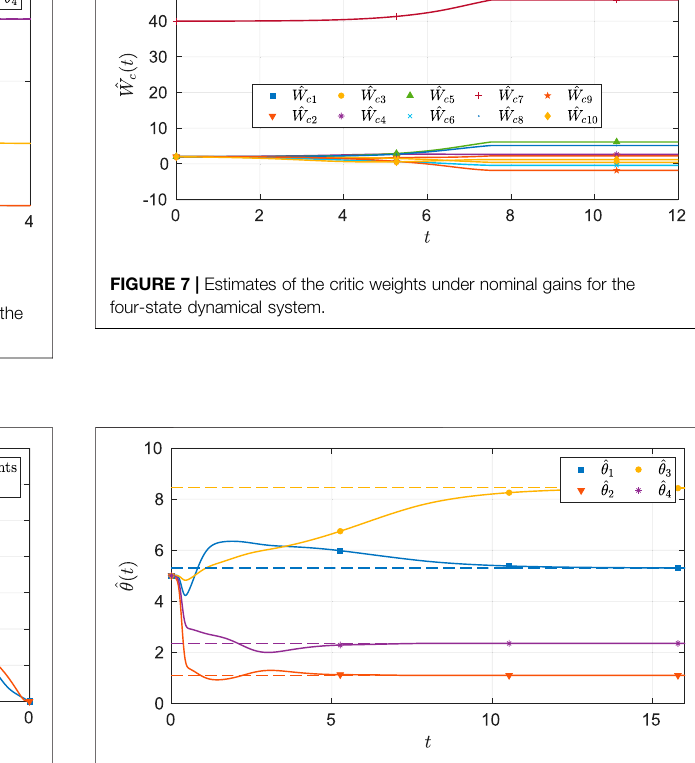
FIGURE 5 | Comparison of the optimal trajectories obtained using GPOPSIIandusingBTMBRLwithFCLand fi xedoptimal weightsforthetwo- state dynamical system.